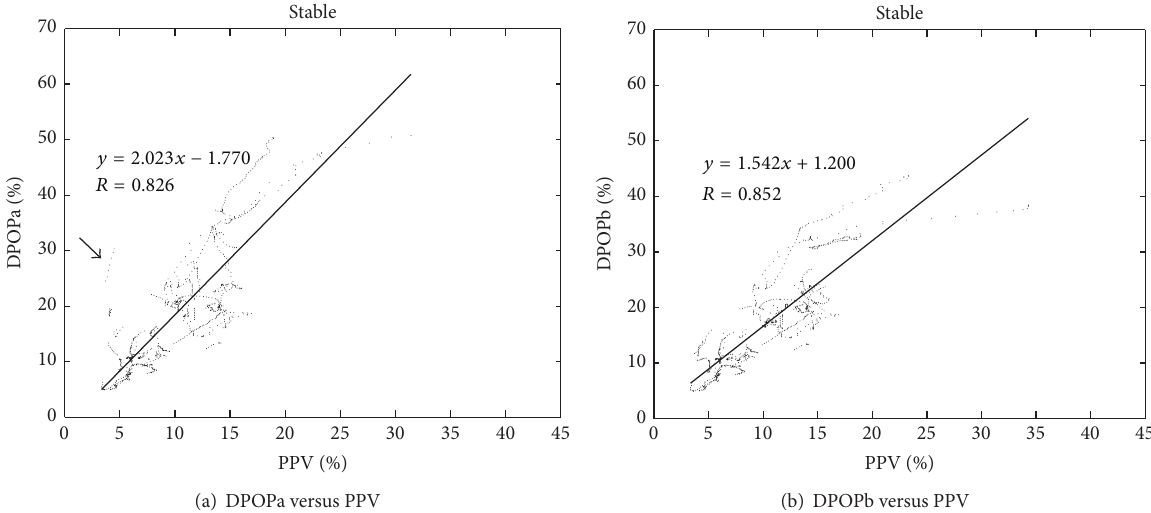
Figure 3: Original and Percent modulation (PMod) corrected DPOP results for stable regions. Note: vertical axes are set to the same scale across plots.